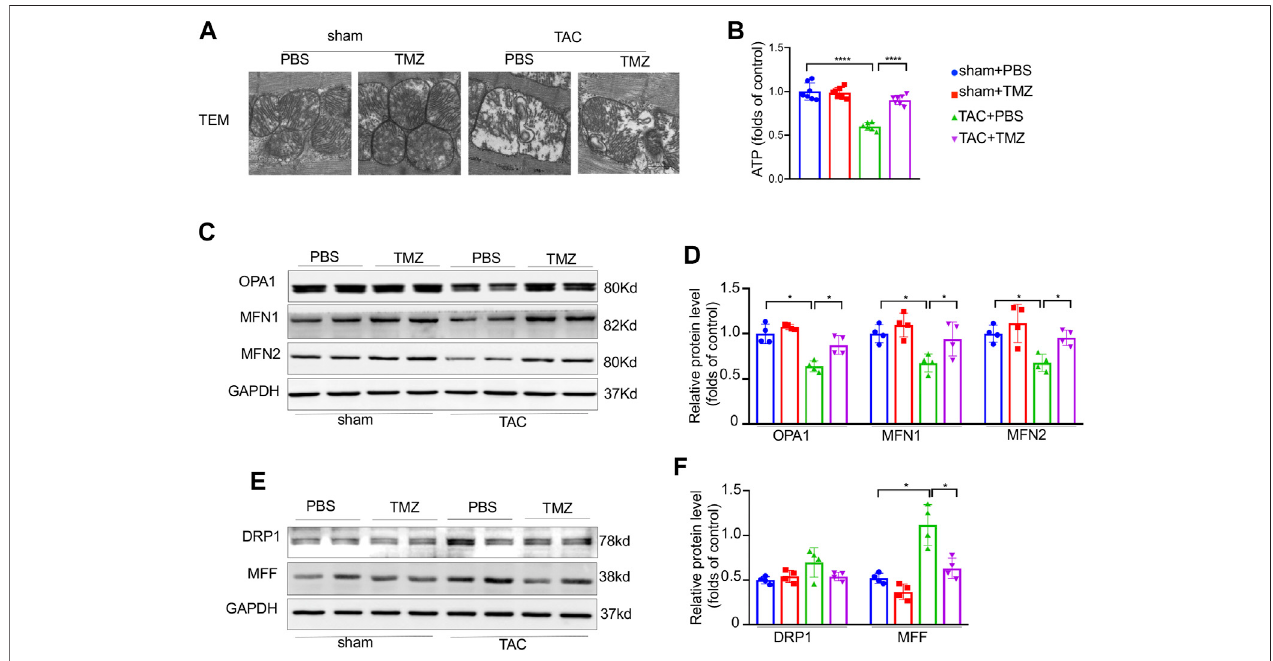
FIGURE 2 | Trimetazidine improved the pressure overload-induced impairment of mitochondrial structure and function. (A) Representative ultrastructure image of mitochondria of mice heart (zoomed scale bar (cid:2) 0.5 um). (B) Cardiac ATP content. (C – F) Representative western blots of mitochondrial dynamic protein and corresponding quantitative results. Four samples were included, Graphical data are shown as mean ± SEM. Two-way ANOVA was used for analysis. * p < 0.05, **** p < 0.0001 vs indicated group. TAC, Transverse aortic constriction; TMZ,